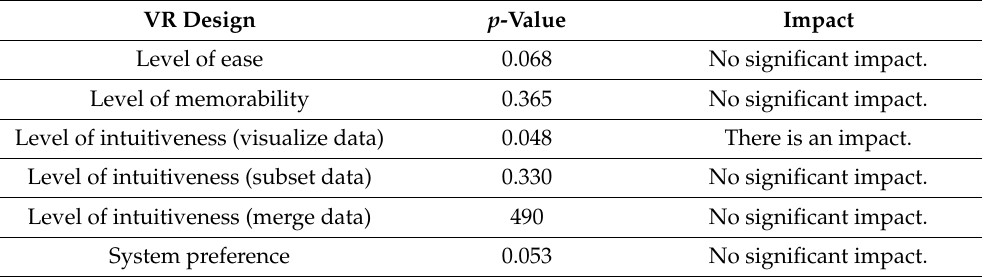
Table 9. Impact of final questions on total completion time in